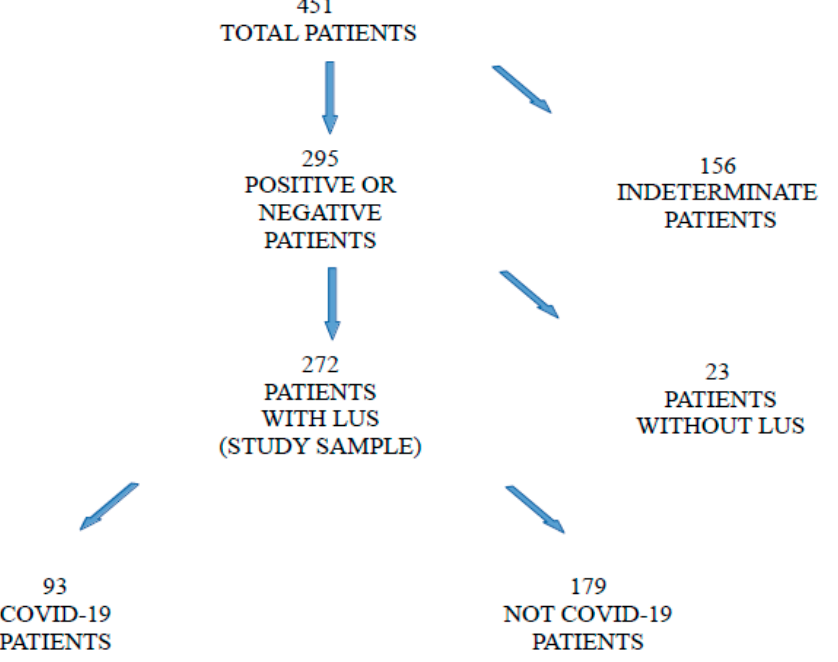
Figure 3. Flow-chart of the